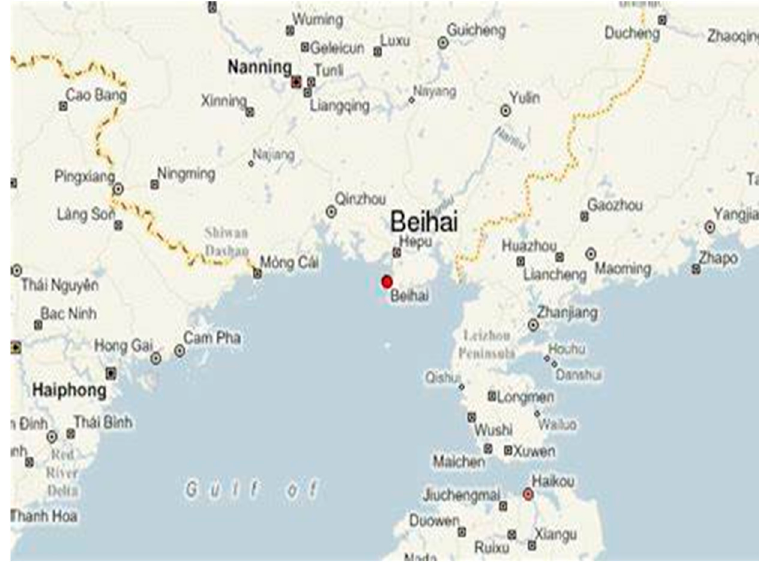
Figure A19. Cs(I) and Sr(II) desorption kinetics for APO-PEI sorbent: case of binary systems (metal- loaded samples collected at equilibrium from the relevant kinetics; SD: 2.67 g L − 1 ; eluent: 0.2 M HNO 3 ; v: 210 rpm; T: 21 ± 1 °C).